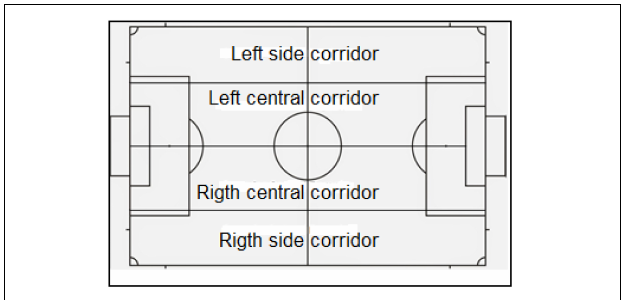
TABLE 2 | Density of players in the elaboration of the play.